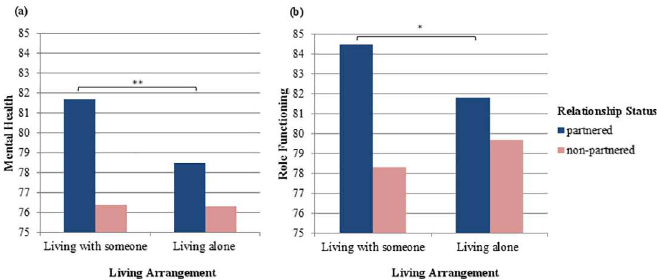
Fig 1. Interaction-effect of relationship status and living arrangement. Note. The y-axes display estimated mean values of (a) mental health and (b) role functioning adjusted for genderand age; * p = .04; ** p < .001.